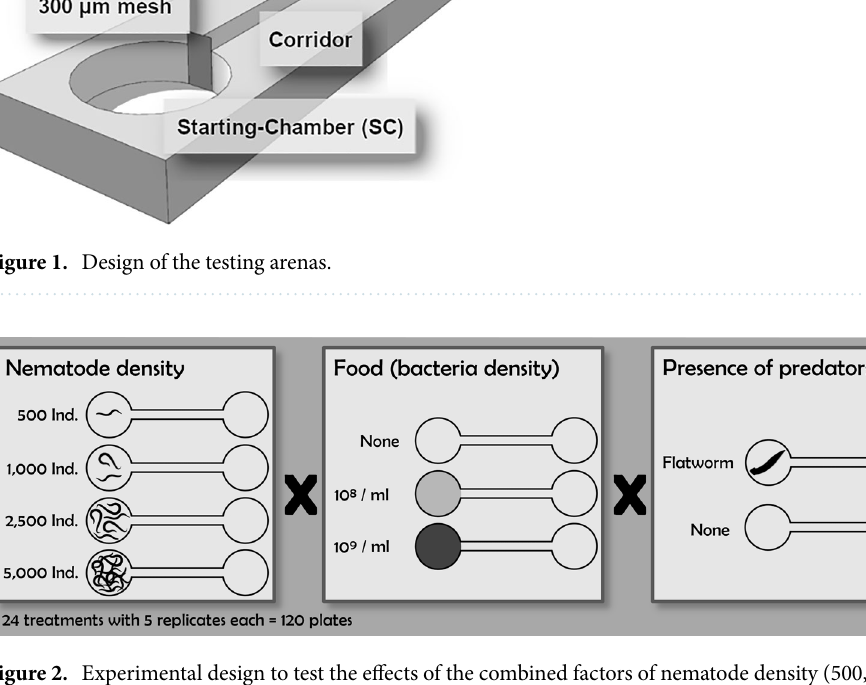
Figure 2. Experimental design to test the effects of the combined factors of nematode density (500, 1000, 2500 and 5000 nematodes per SC), food availability (no bacteria, 10 8 and 10 9 cells ml −1 ), and the presence or absence of a predator in the